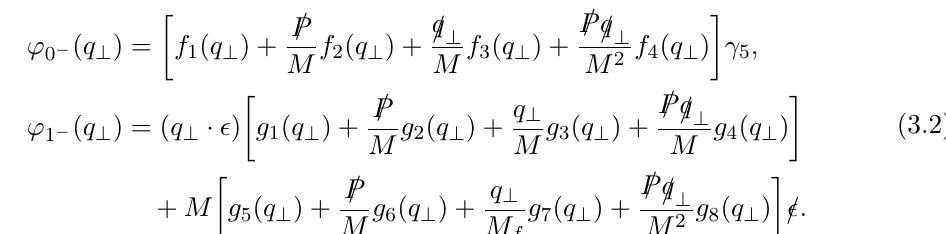
2 deduced from B (cid:0) g p 4 j j